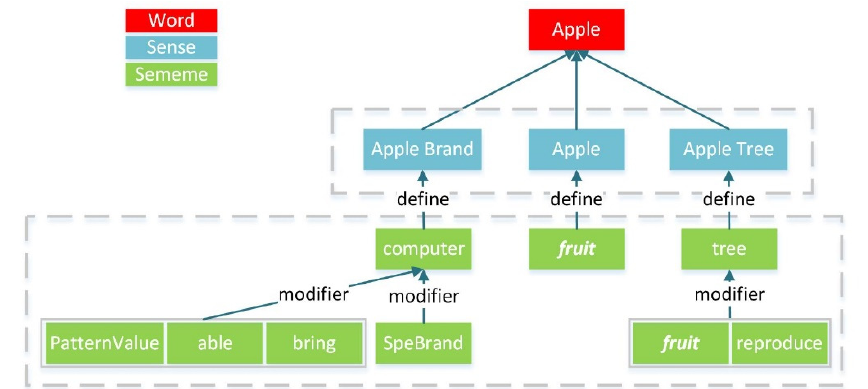
Figure 1. An example of the word–sense–sememe structure, where sememes are defined as minimum units of word meanings. There exists a limited close set of sememes to compose the open set of word meanings (i.e., word sense). For instance, the word (the first layer) “Apple” contains three senses (the second layer): “Apple Brand” (a famous computer brand), “Apple” (a sort of fruit) and “Apple Tree”. The third layer is those sememes explaining each sense. The sememes of sense “Apple Brand” are “computer”, “PatternValue”, “able”, “bring” and “SpeBrand (specific brand)”. The sememe of sense “Apple” is “fruit”. The sememes of sense “Apple Tree” are “fruit”, “reproduce” and “tree”. SE-WRL model believes that contributions of each sememe under a sense are